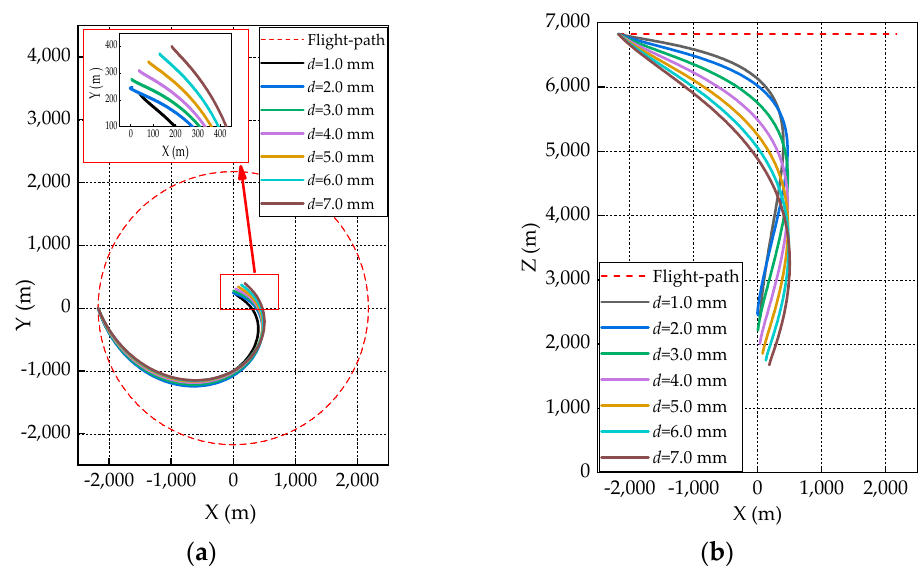
Figure 8. Towline spatial configurations vs. towline diameter: ( a ) Two-dimensional projection in horizontal plane. ( b ) Two-dimensional projection in vertical plane.